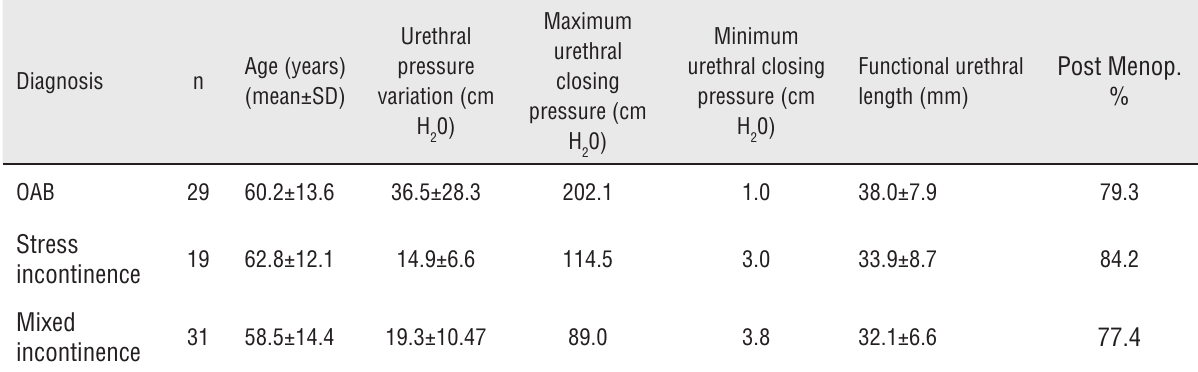
Table 1 - Main patient’s